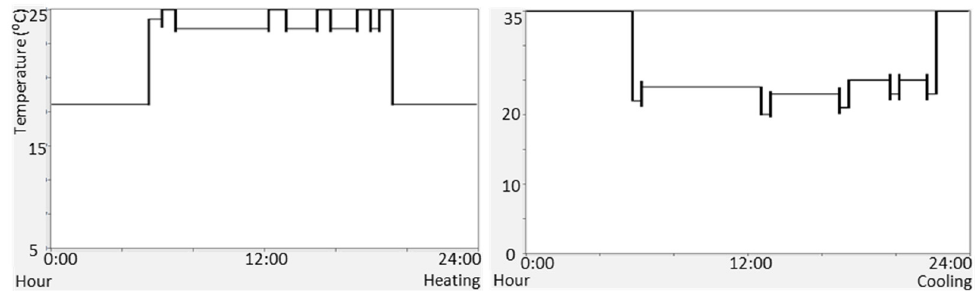
Figure 5. The heating and cooling system schedules of the base scenario.